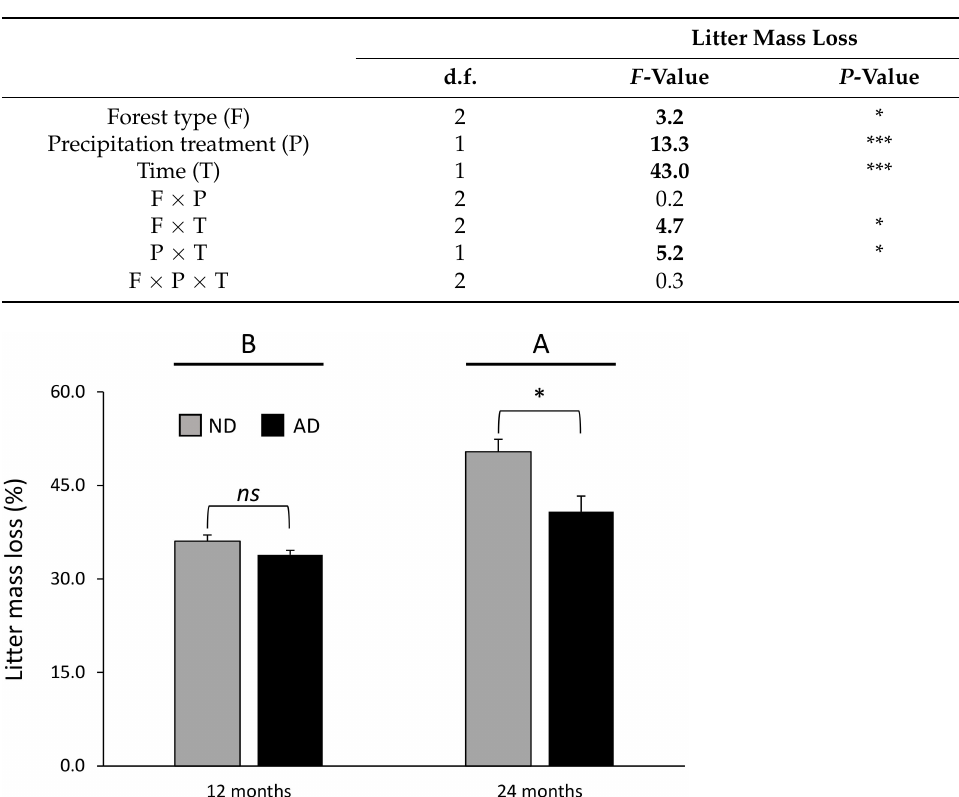
Table 2. Effects of forest type ( P. halepensis , Q. ilex and Q. pubescens ), precipitation treatment (natural or amplified drought), time (12 or 24 months) and their interactions on litter mass loss. F -values and associated P -values (* for P < 0.05 and *** for P < 0.001) are indicated. Significant values are indicated in bold.